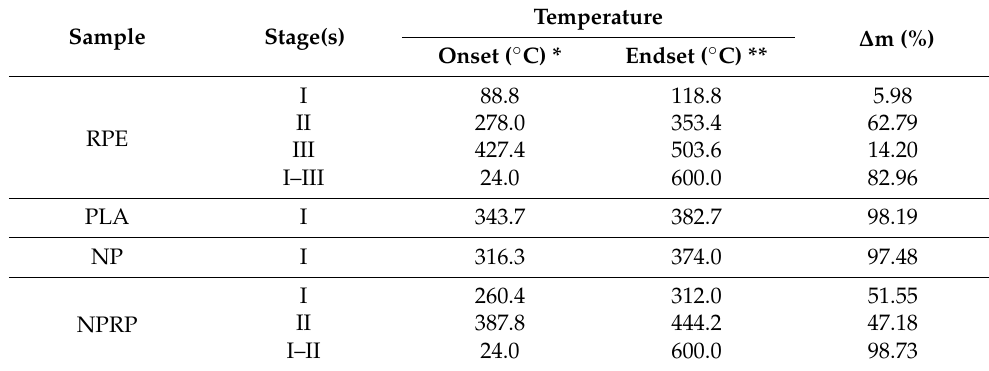
Table 5. Thermogravimetric events of RP, PLA, NP, and